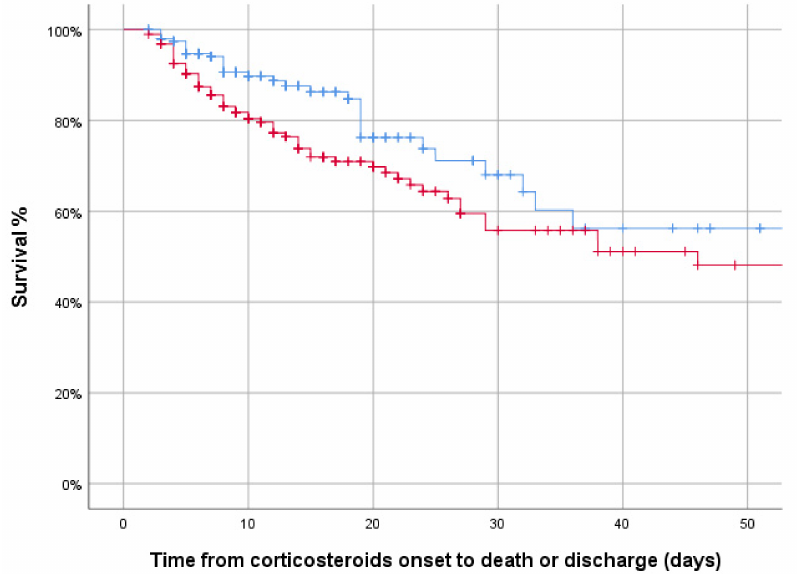
Figure 2. In-hospital mortality between groups in the matched sample: 3-day MP pulses (red) vs. DXM (blue). Kaplan–Meier curves. Log-rank test 2.849 p =